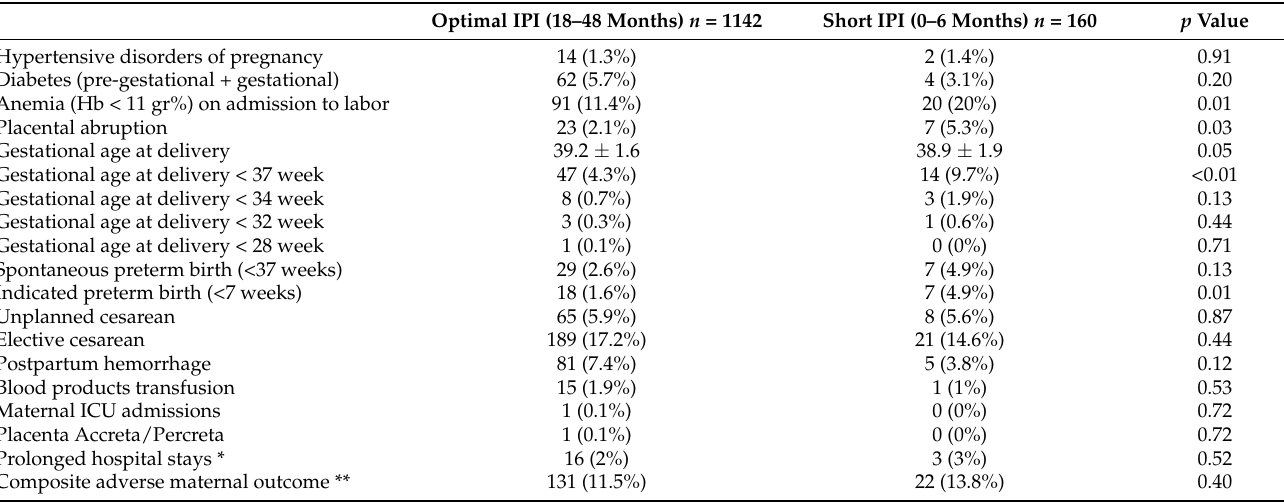
Table 2. Maternal outcomes of singleton delivery following short versus optimal IPI from a twin delivery.